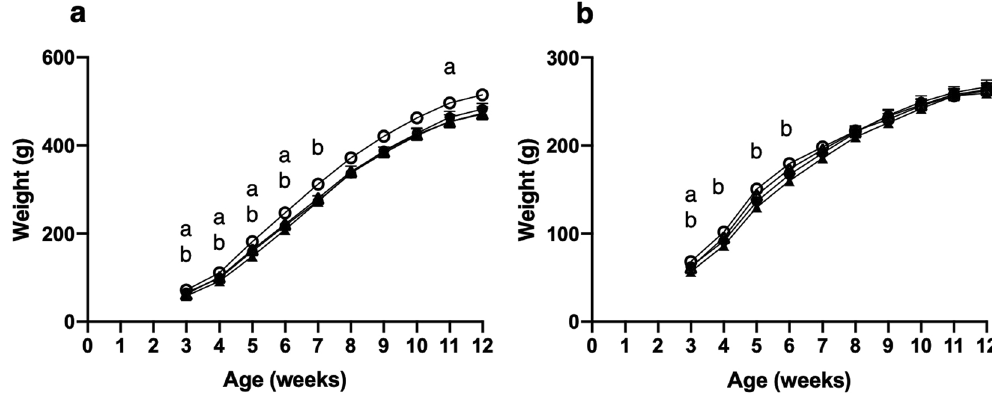
Figure 1. Offspring weight from weaning to 12 weeks of age. Values are for are mean and SEM. ( a ) Male offspring, ( b ) Female offspring. Four groups of cross-fostered offspring were studied: offspring exposed to a chow diet during pregnancy cross-fostered to a chow fed dam during lactation ( CC, n 16) or a cafteria fed dam ( CO, n 15–16), offspring exposed to a cafeteria diet during pregnancy cross-fostered to a chow fed dam during lactation ( OC, n 13–16) or a cafeteria fed dam